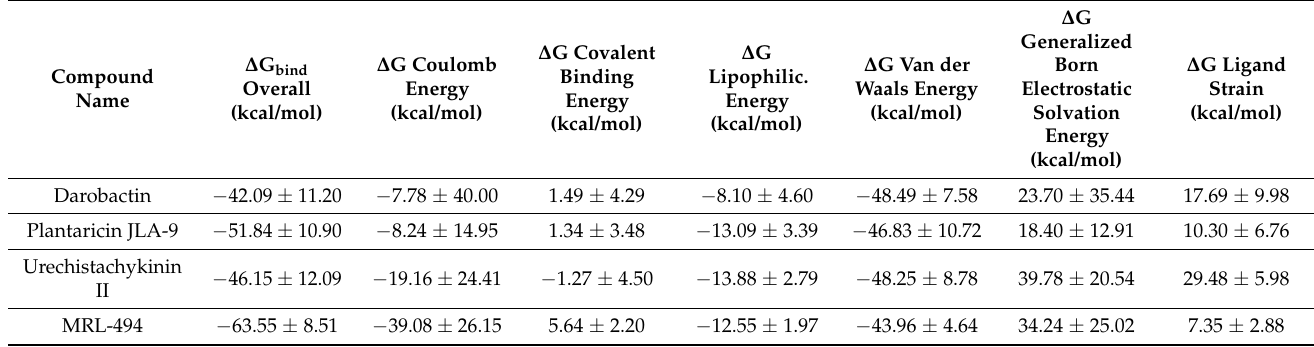
Table 4. AMPs screened by APD3 and the SP-peptide mode docking score and interactions with the